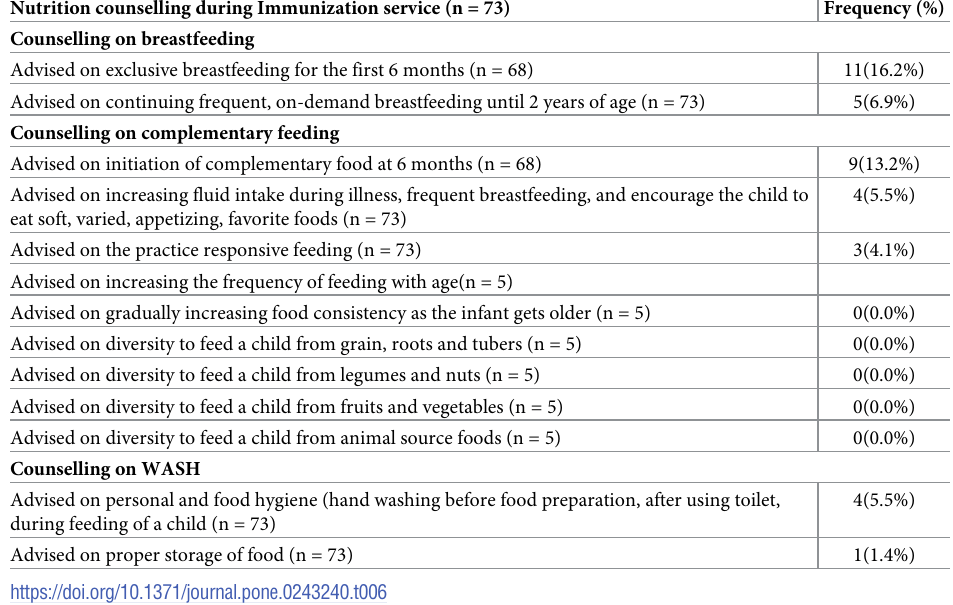
Table 6. Proportion of mothers receiving nutrition counselling at the immunization service provision